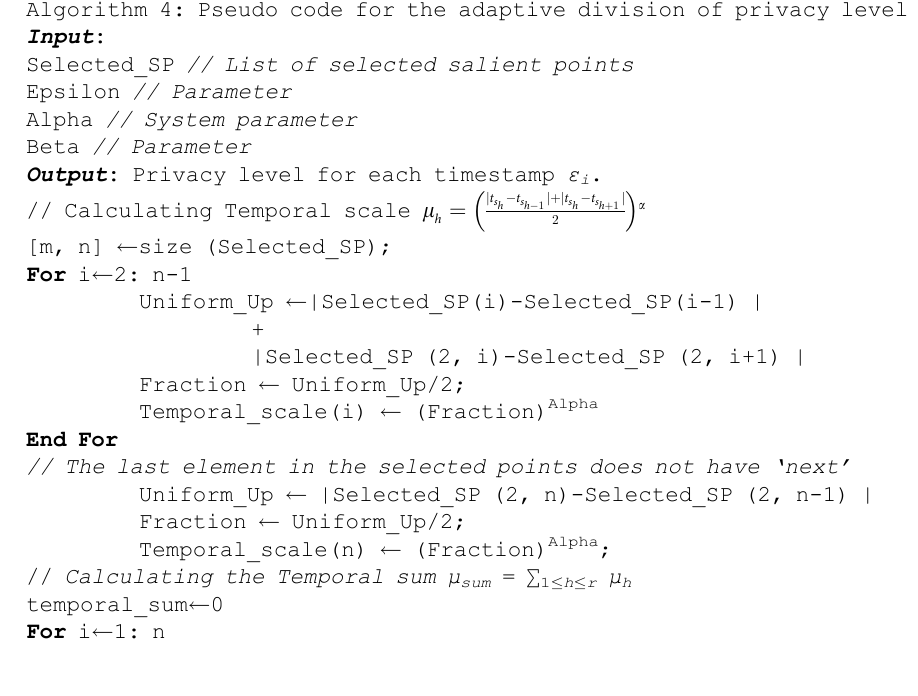
Algorithm 4: Pseudo code for the adaptive division of privacy level